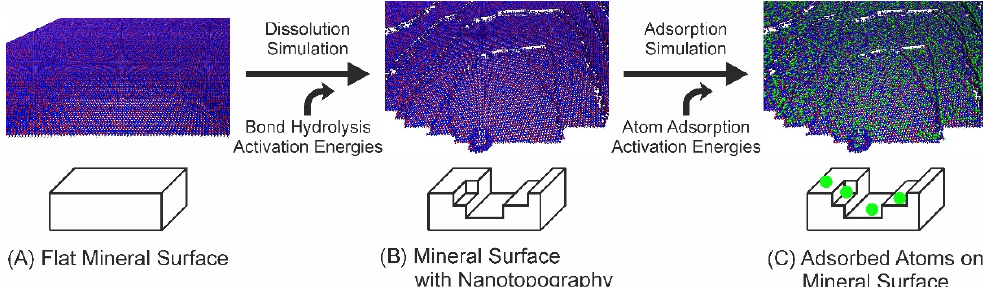
Figure 1. Conceptual overview of the kinetic Monte Carlo workflow in this study combining simulation results (Top) and respective nanotopography sketches (Bottom). ( A ) An atomically flat muscovite surface is modified by etch pit placement and following simulation of dissolution. The surface color represents the surface cation atom with blue for silicon and red for aluminum atoms. ( B ) The resulting nanotopographic surface is used as a substrate for the simulation of radionuclide adsorption. Parameters such as step height, step shape (straight, curved), and step orientation play a key role in describing nanotopography. ( C ) Muscovite surface after an example of adsorption simulations shows the distribution of adsorbed radionuclide atoms (green color).